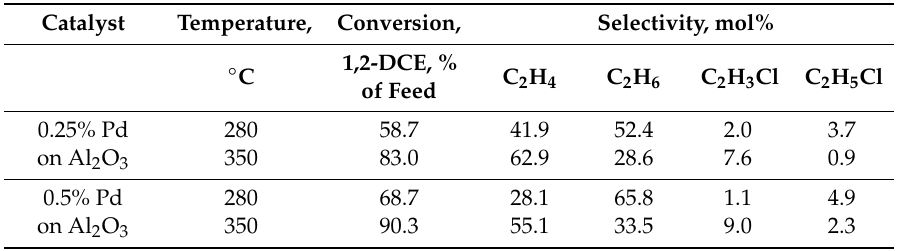
Table 8. Activity and selectivity of various catalysts in 1,2-dichloroethane hydrodechlorination residence